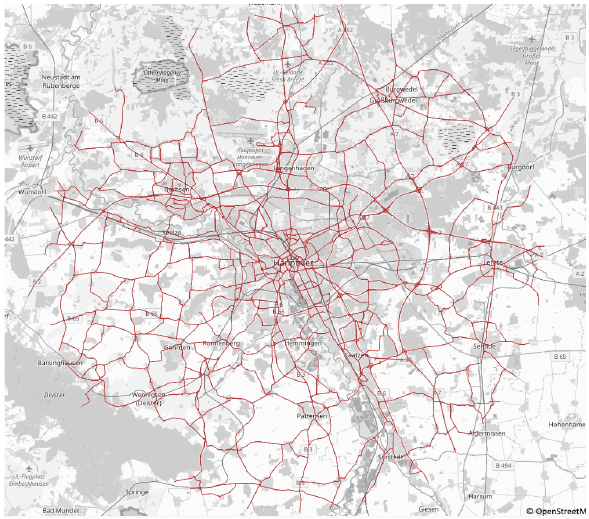
Figure 1. An overview of the considered road segments of the FCD set. [source: Stamen map tiles and OSM] Hanover city and we are not able to sense traffic flowing into res- idential blocks. Figure 1 provides an overview of the road seg- ments contained in the dataset. The records contain information regarding the measured traffic speed on the individual street seg- ment of the street network at discrete time points i.e. the speed is recorded every 15 minutes. Note that this kind of information can easily be extracted from more commonly available floating car data. The dataset covers the time span from October 2017 to January 2018 and all street segments of the aforementioned cate- gory that are located within a distance of 20 km from the